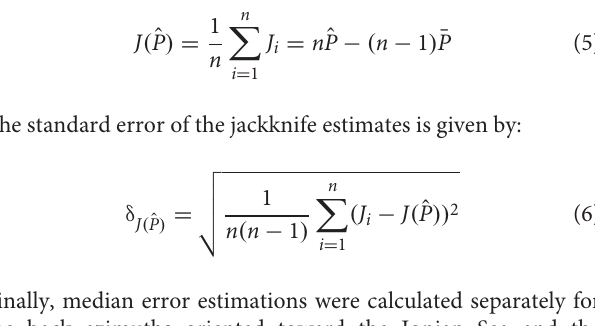
To evaluate the error associated with the back azimuth estimation, the jackknife technique (Efron, 1982) was employed technique by using all the seven stations composing the